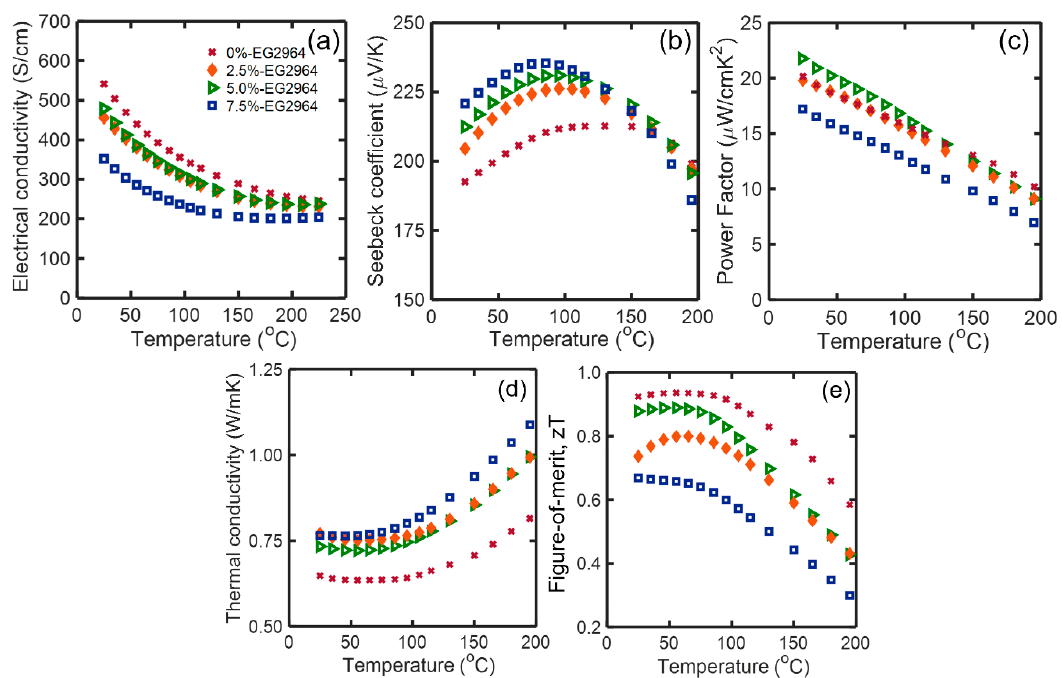
Figure 3. Effect of 0, 2.5, 5 and 7.5 wt% of EG2964 glass on ( a ) electrical conductivity, ( b ) Seebeck coefficient, ( c ) PF, ( d ) thermal conductivity and, ( e ) zT of (Bi 0.25 Sb 0.75 ) 2 Te 3 .